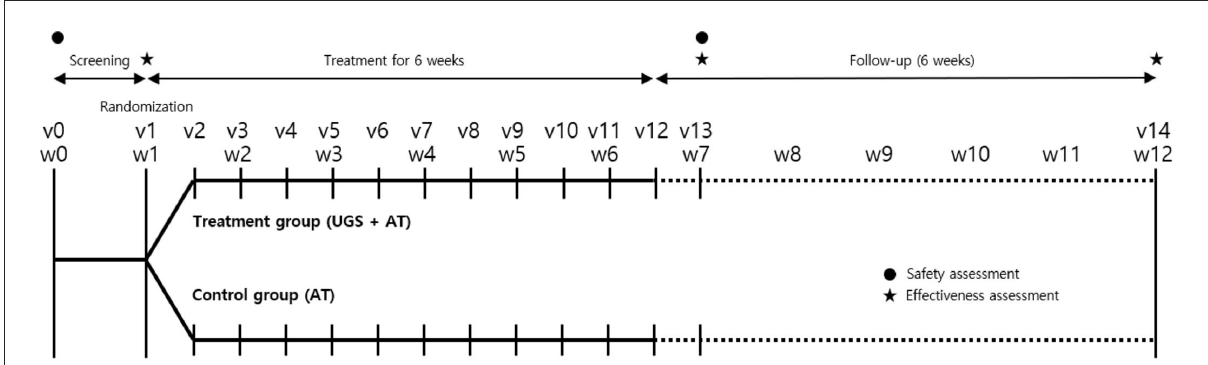
FIGURE1 Timeline of study. The vertical lines indicate the time points of the actual visit for trial, and the dotted lines show the observation period after the intervention. Clinical effectiveness was assessed with the Movement Disorder Society-Unified Parkinson’s Disease Rating Scale (MDS-UPDRS), the modified Hoehn and Yahr staging scale (H–Y scale), Schwab and England Activities of Daily Living (SE-ADL) Scale, Berg balance test (BBT), Timed Up and Go test (TUG), 39-item Parkinson’s Disease Questionnaire (PDQ-39), and five-level version of European Quality of Life Scale Five-Dimensional Questionnaire (EQ-5D-5L) score. Self-reported adverse events and measured vital signs were evaluated at each visit. Electrocardiogram and blood sampling were performed before and after treatment for safety assessment. v, visit; w, week; UGS, Ukgansan; AT,